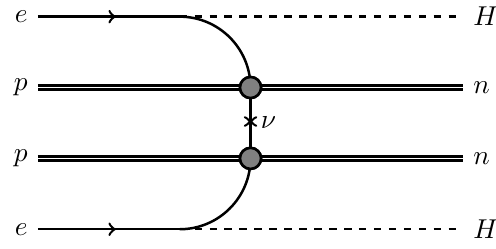
Figure 3 . Feynman diagam for the Majorana mixing amplitude of A Z atom in the ground state and the 2-hole A ( Z (cid:0) 2) (cid:3)